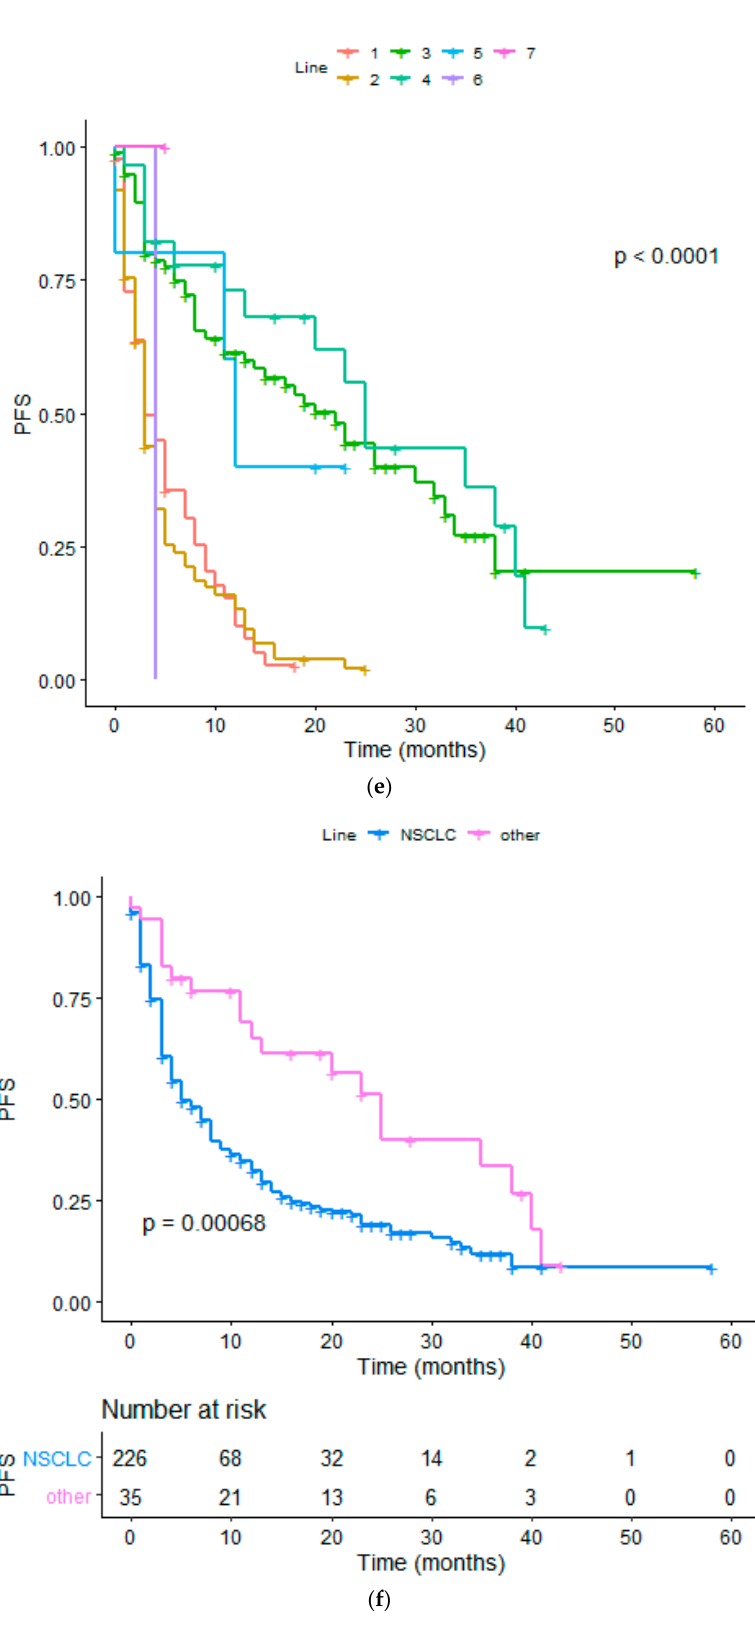
Figure 4. ( a ) PFS in patients with and without liver metastases; ( b ) PFS in patients with and without brain metastases; ( c ) PFS in patients with and without bone metastases; ( d ) PFS in patients treated with immunotherapy upfront or in subsequent lines; ( e ) PFS in di ff erent histologies; ( f ) PFS in patients a ff ected by squamous and non-squamous NSCLC or other